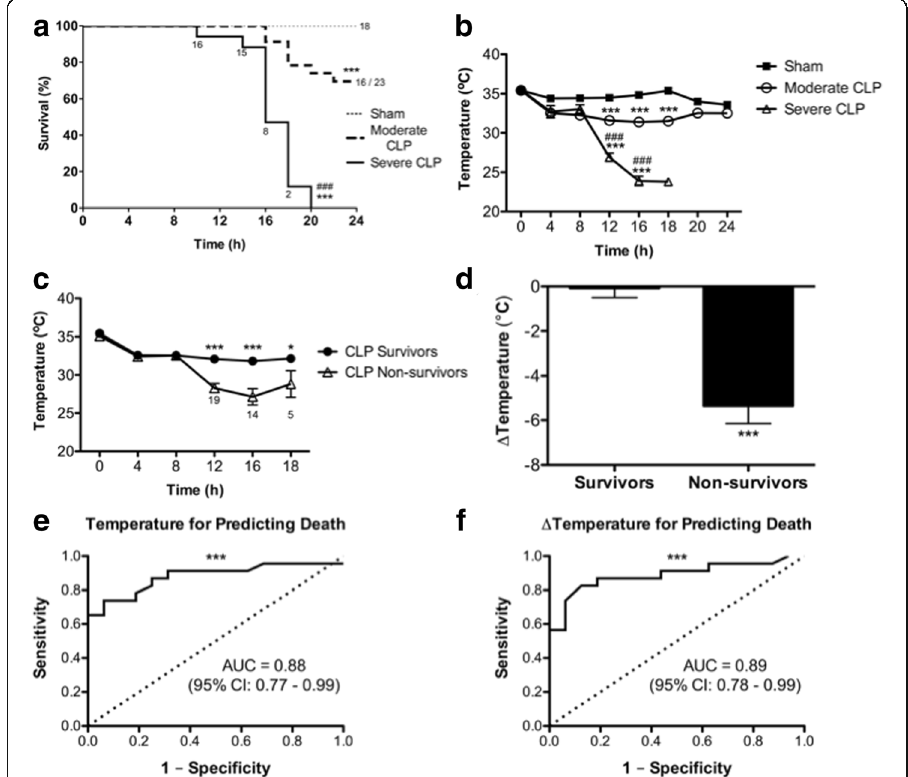
Fig. 1 Kaplan-Meier survival curves ( a ) and body temperature over time in sham, moderate, or severe CLP mice ( b ), temperature ( c ), and change in temperature ( d ) over time in survivors vs. non-survivors, and ROC analyses of last body temperature ( e ) and change in body temperature ( f ) as predictors of death in septic mice. Data are presented as mean ± SEM from six independent experiments representing a total number of n = 18 sham, n = 23 moderate CLP, and n = 17 severe CLP mice; * p < 0.05, ** p < 0.01, *** p < 0.001 (vs. sham in ( a , b )), # p < 0.05, ## p < 0.01, ### p < 0.001 vs. moderate CLP, by two-way ANOVA (or by Mantel-Cox